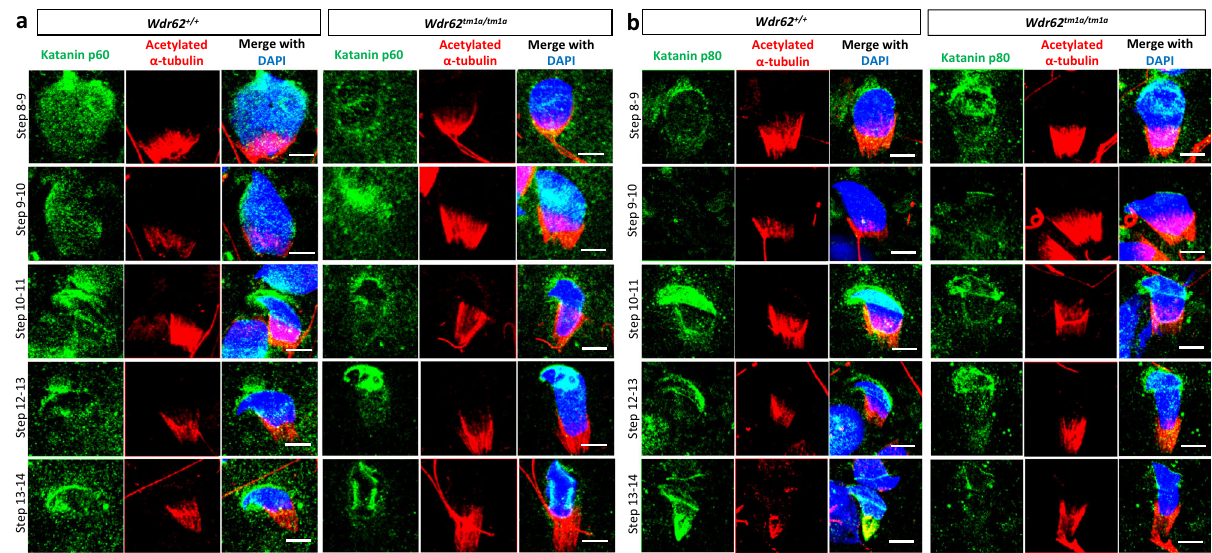
Fig. 6 Wdr62 tm1a/tm1a spermatids exhibit defective manchette removal. a Katanin p60 (KATNA1, green) and acetylated α -tubulin (red) co- immuno fl uorescence on adult spermatocyte spreads. Representative images of co-staining in step 8 – 14 spermatids are shown. Scale bar represents 5 μ m. b Katanin p80 (KATNB1, green) and acetylated α -tubulin (red) co-immuno fl uorescence on adult spermatocyte spreads. Representative images of staining in step 8 – 14 spermatids are shown. All spermatids are counterstained with DAPI (blue) in ( a ) and ( b ). Scale bars represent 5 μ m. Negative IgG controls for ( a ) and ( b ) are shown in Supplementary Fig.